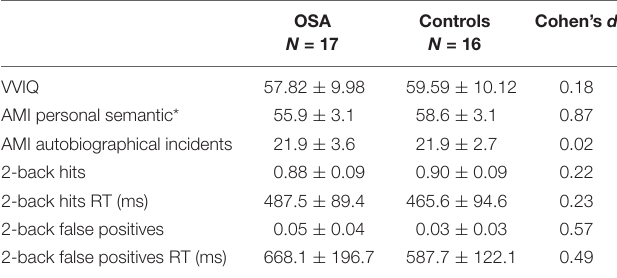
TABLE 2 | Behavioral outcomes for the OSA and healthy control